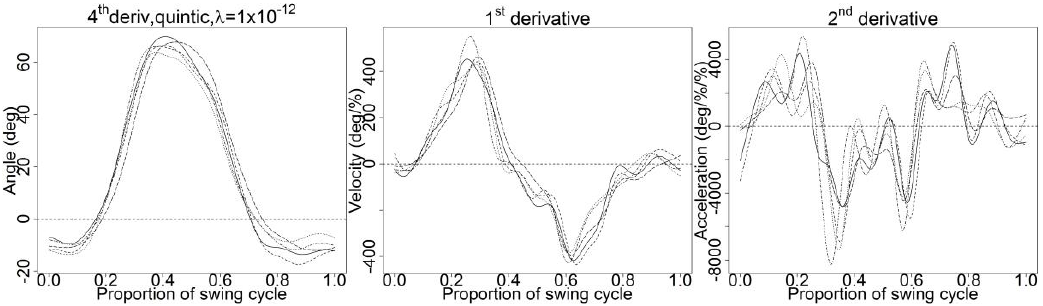
Figure 5. Smoothing using quintic spline basis,